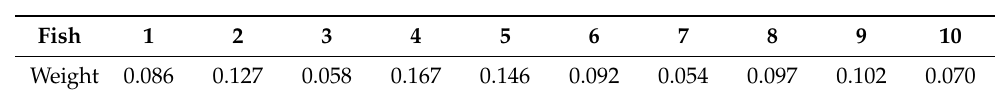
Table A20. Weight of each criterion for